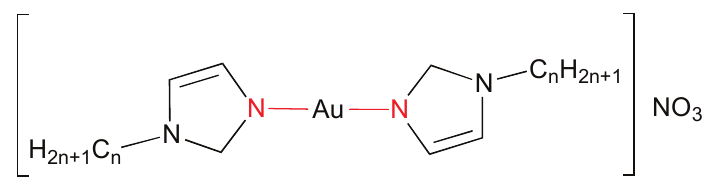
-im: n = 12, 14, 16, 18. n